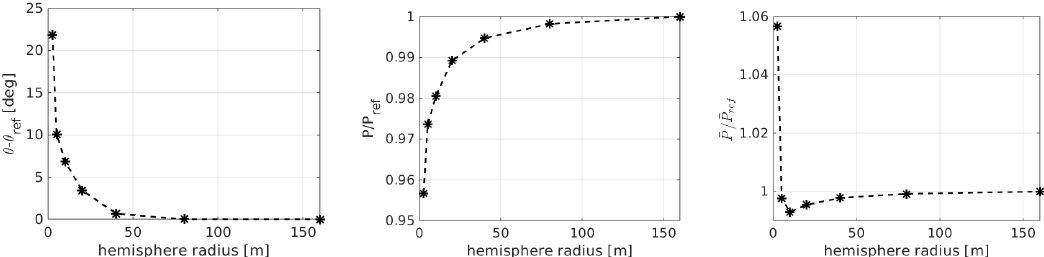
Figure 14. Convergence analysis as observer distance